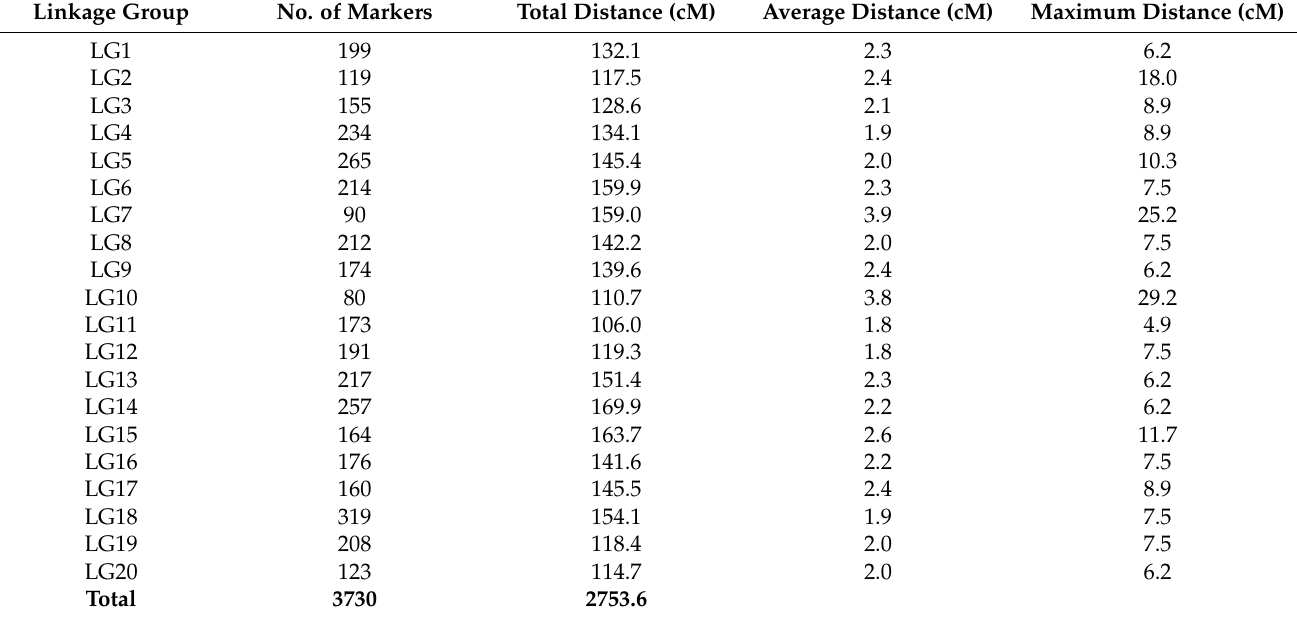
Table 2. Summary of genetic linkage map of Muscadinia rotundifolia cv. Dixie developed with SNP markers revealed using chromosome sequences of M. rotundifolia cv.